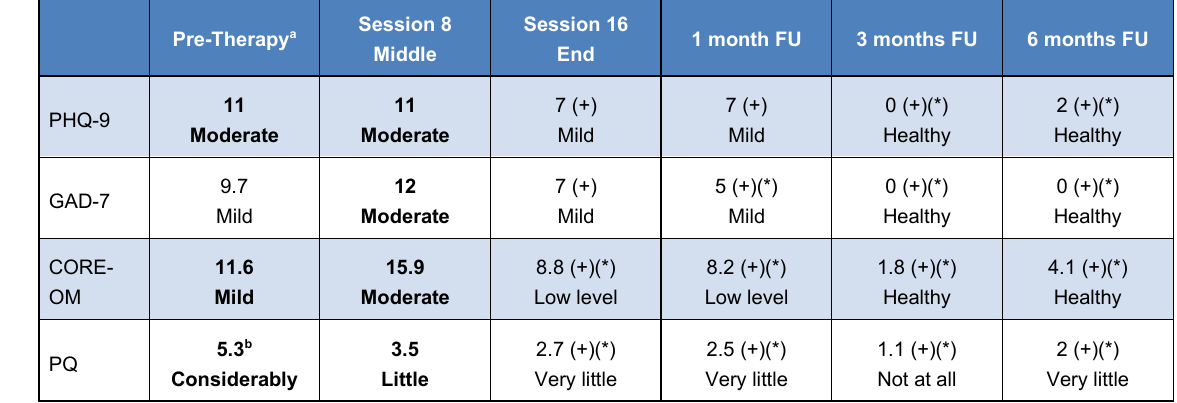
Note . Values in bold are within the clinical range; + indicates clinically significant change (CS). * indicates reliable change (RC). FU = follow-up. PHQ-9 = Patient Health Questionnaire 9-item for depression (Spitzer, Kroenke & Williams, 1999). GAD-7 =